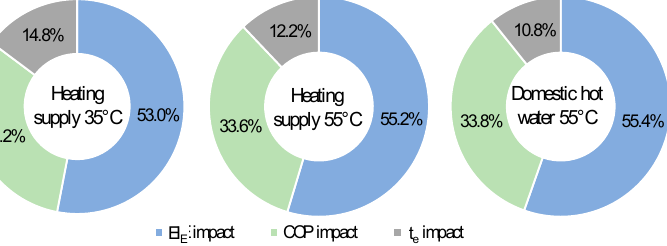
Figure 10. The influence weight of EI E , COP and t e as emission factors of air source heat